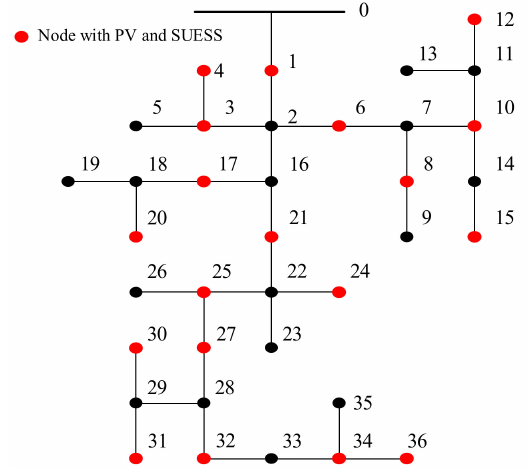
Figure 5. Modified IEEE 37 test